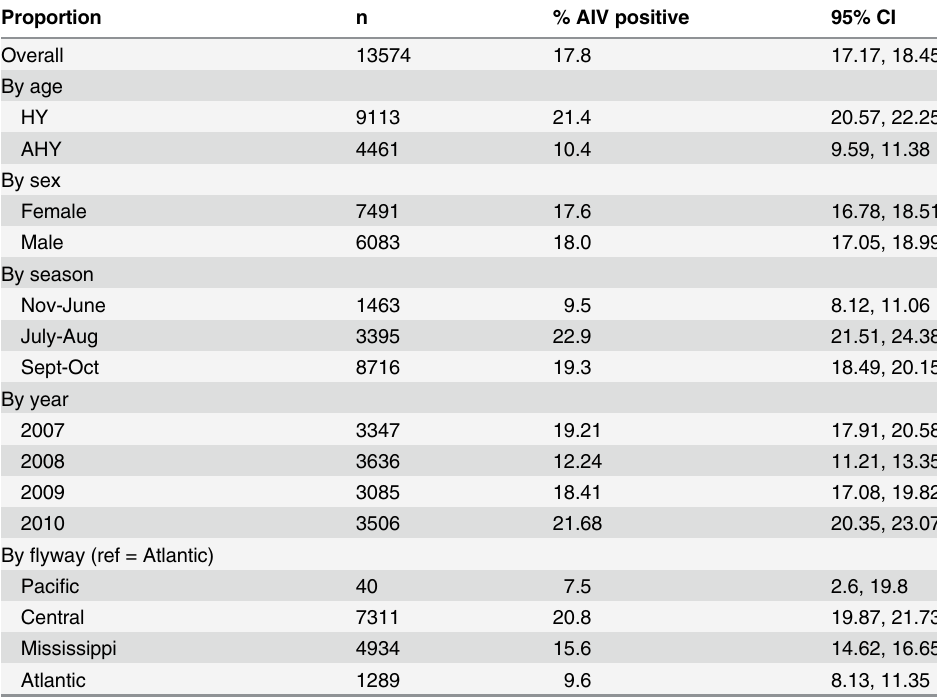
Abbreviations: HY = hatch year (including SY), AHY = after hatch year (including ASY), AIV = Avian in fl uenza virus matrix protein